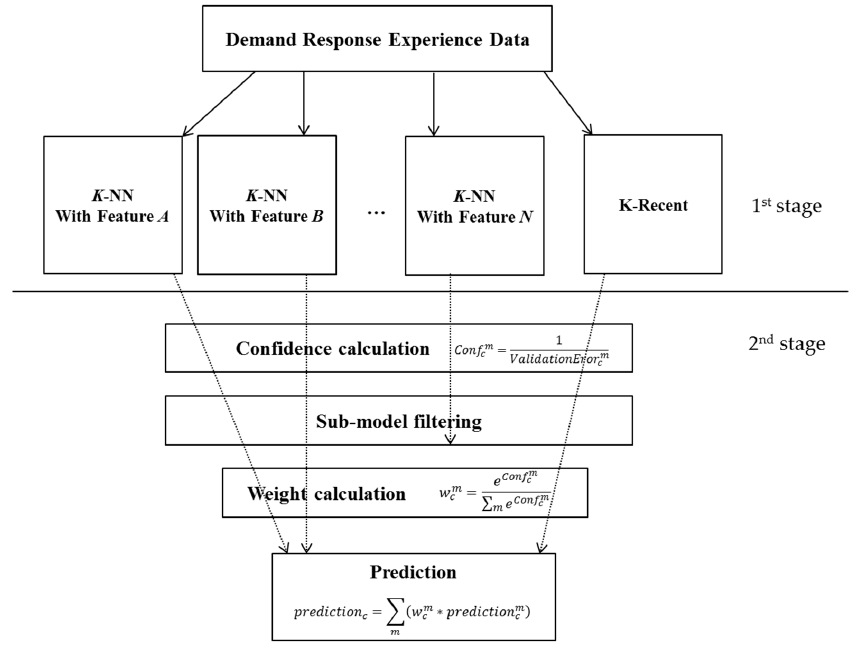
Figure 3. The proposed prediction model. Table 1. Features used in the prediction.